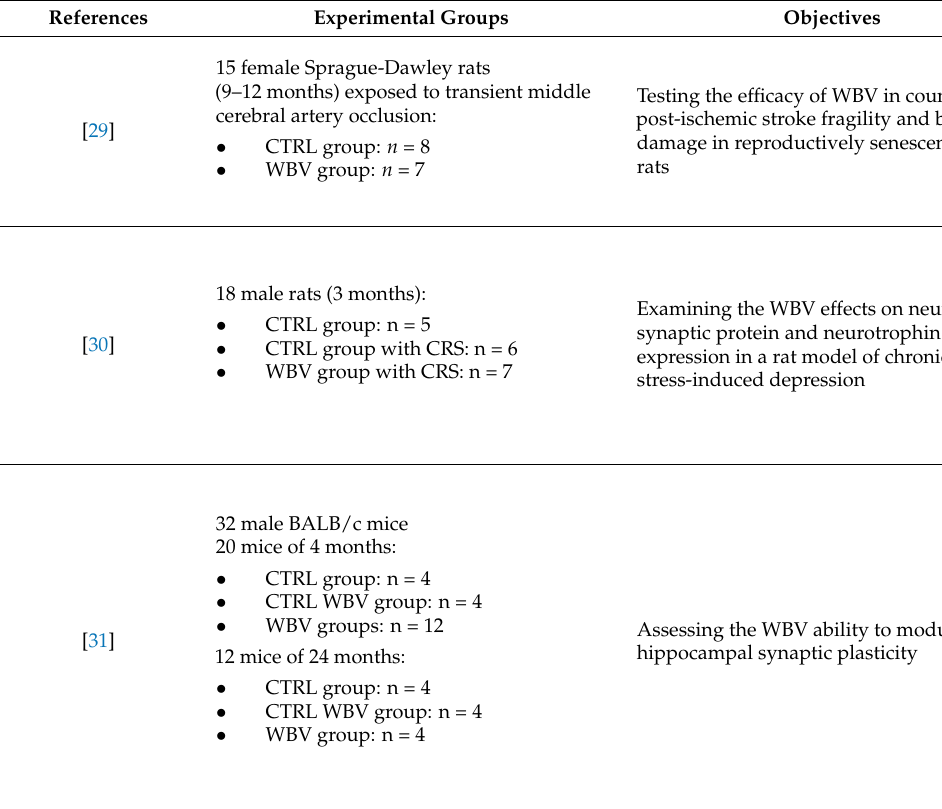
Table 1. A schematic representation of the main scientific evidence on the WBV